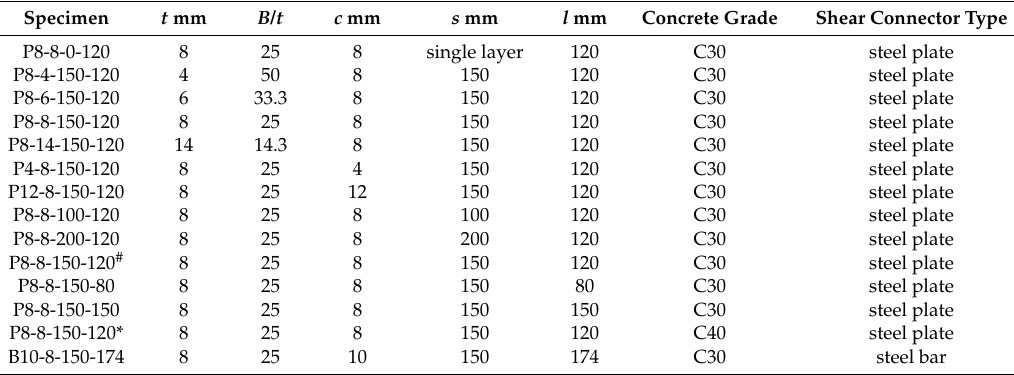
Table 1. Parameters of square CFST specimens.